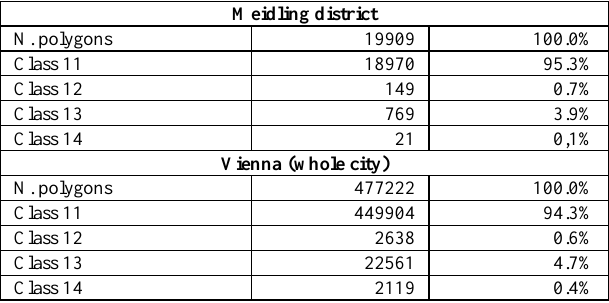
Table 2. Distribution of object classes in Meidling and Vienna (whole city).